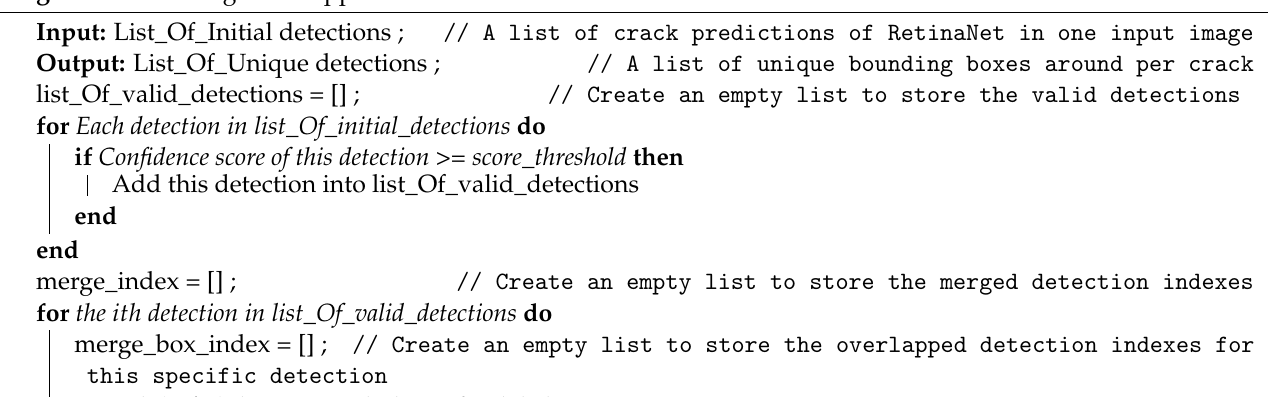
Algorithm A1: Merge overlapped